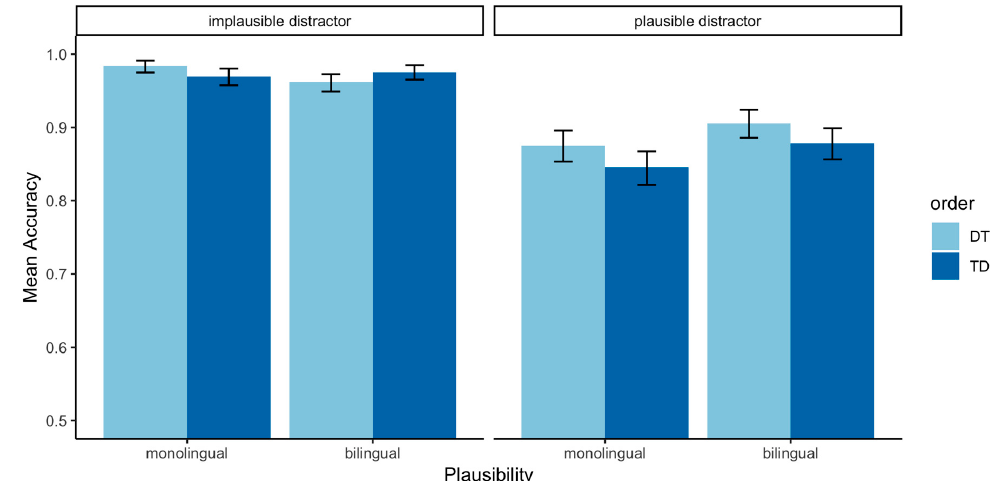
Figure 2. Accuracy in selection of the target verb by condition. Error bars indicate 95% confidence intervals.